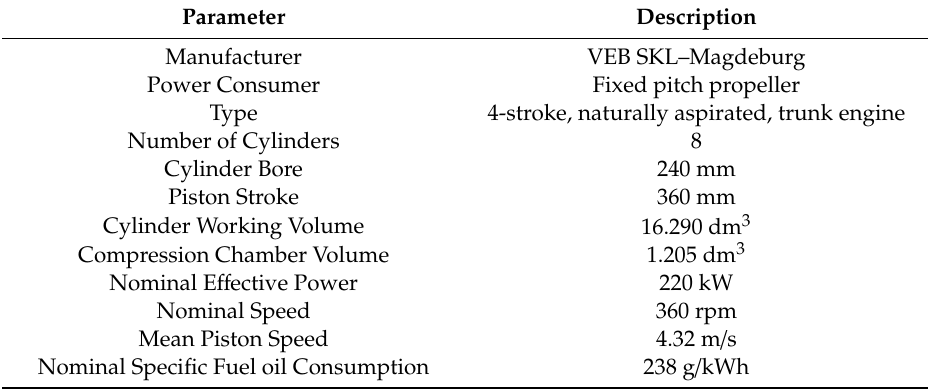
Table 2. The basic technical and operational parameters of a Buckau-Wolf R8DV-136 Engine.